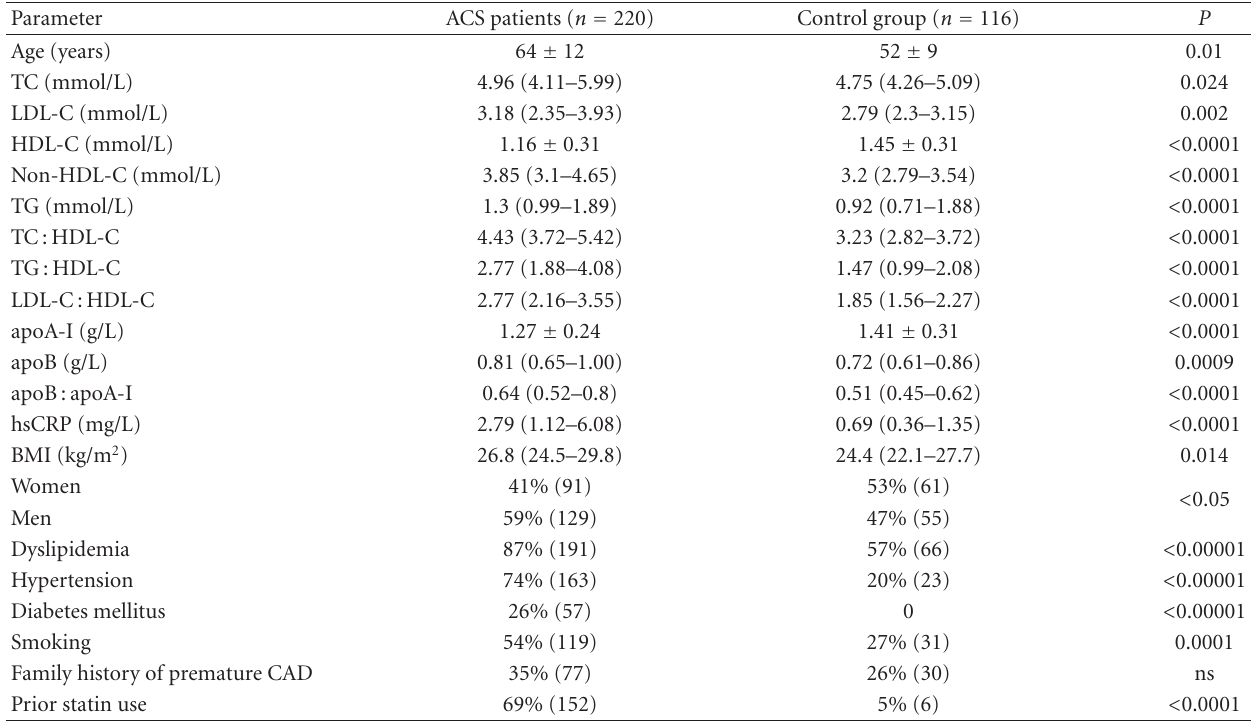
Table 1: Baseline characteristics of the study